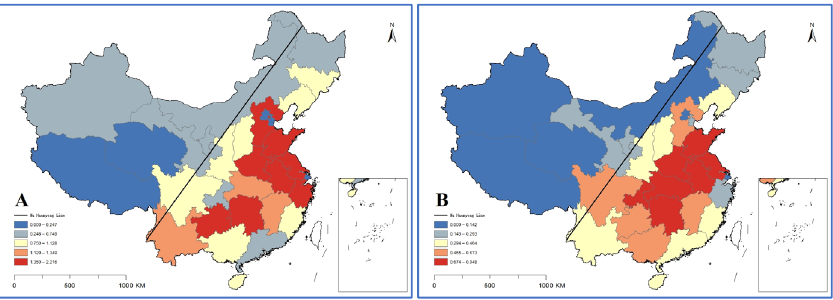
Figure 5. HRDI distribution map of beds in 2020 (( A ) for county and county-level city medical and health institutions; and ( B ) for township hospitals).